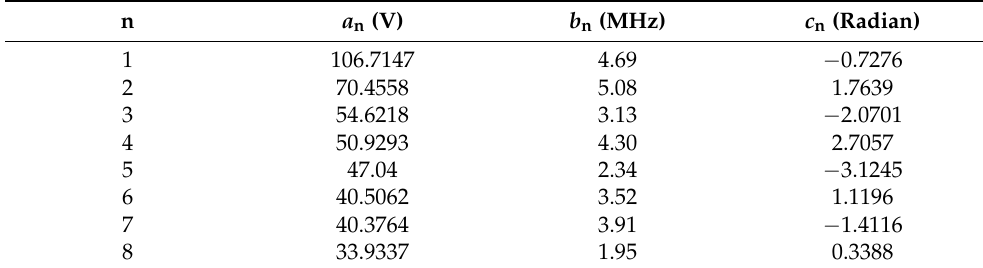
Table 1. Coefficients for curve fitting.